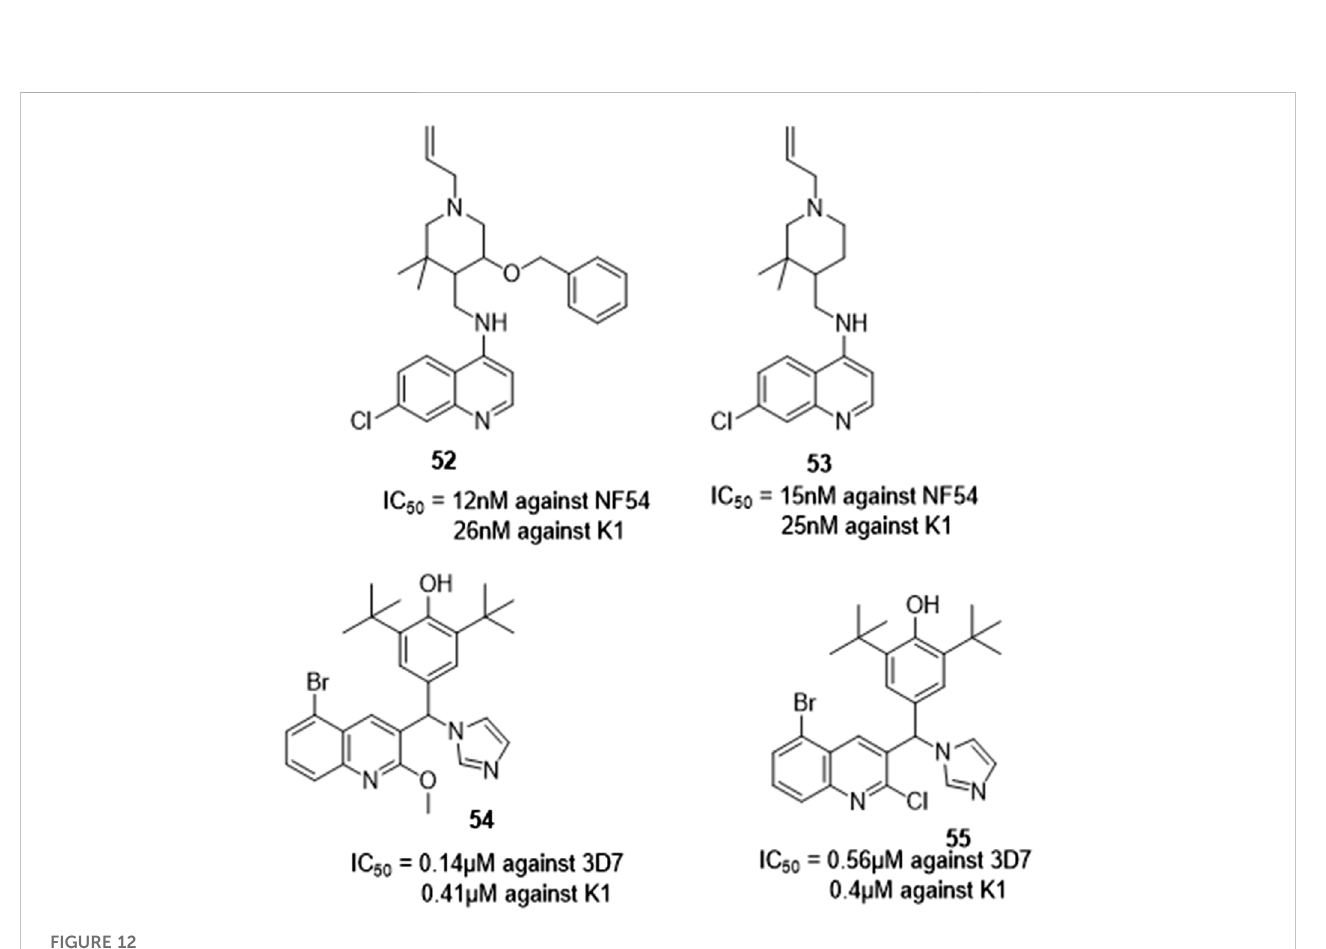
FIGURE 12 quinoline derivatives with antimalaria